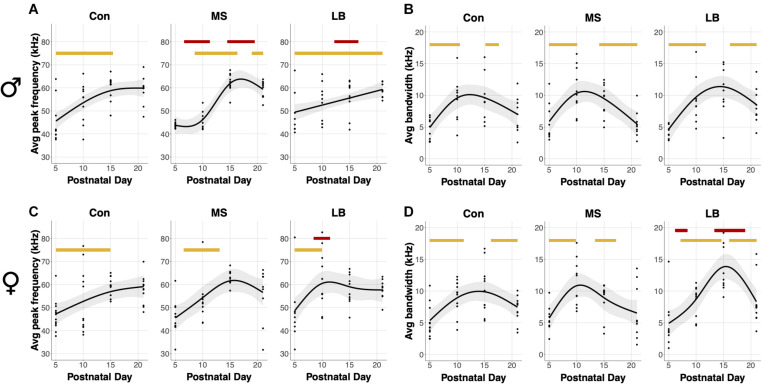
Effects of age and maternal separation (MS) or limited bedding (LB) on peak frequency and bandwidth averaged across all USVs for each subject. Age related increases or decreases are indicated by orange bars. (A) In males, peak frequency was decreased by MS P6.61-P11.27 and increased by MS P14.49 and P19.47. LB peak frequency was decreased in males P12.24-16.58. (B) There was no effect of MS or LB on developmental changes in bandwidth in males. (C) In females, LB increased peak frequency from P8.46-P11.43. (D) LB decreased the bandwidth of female calls from P6.21-P8.38 and increased the bandwidth from P13.36-P18.91 n = 8–10.